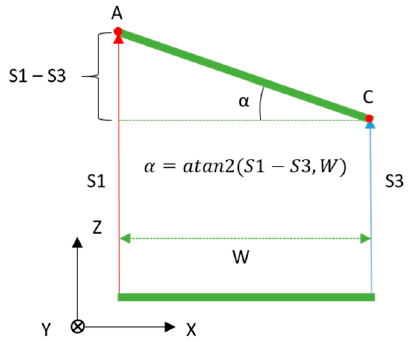
Figure 12. Estimation of relative surface rotation, about Y axis, with respect to compliant wrist base plate. base